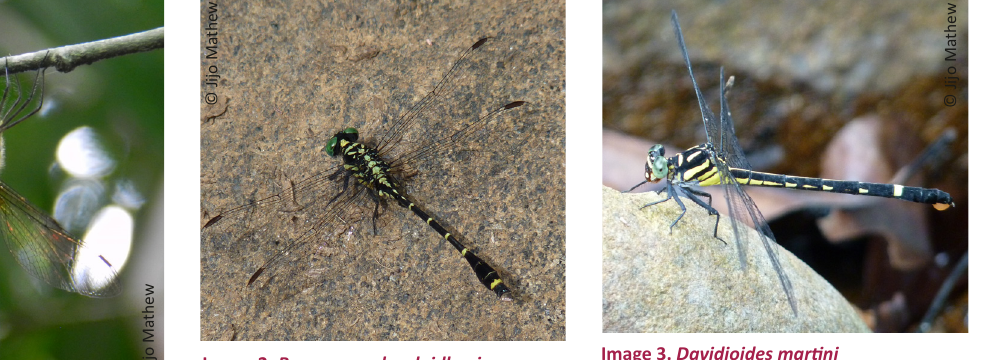
Image 3. Davidioides martini Image 2. Burmagomphus laidlawi